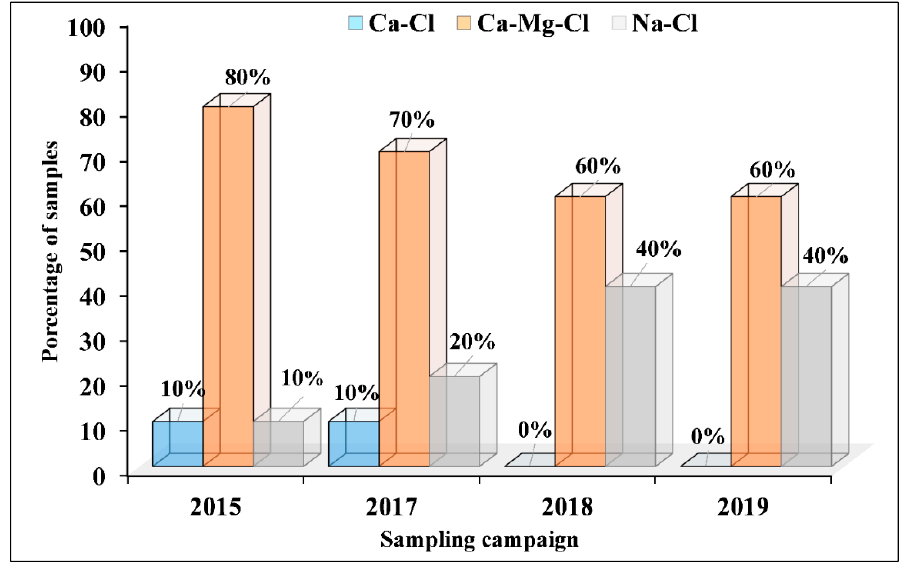
Figure 11. Distribution of hydrochemical facies for the four sampling campaigns.